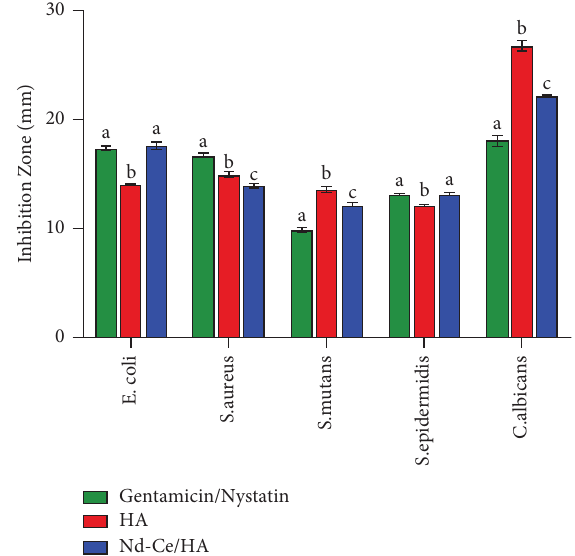
Figure 6: Bar graph exhibited antibacterial and fungicide activity of HA and Nd-Ce/HA (diferent letters ( a , b , c ) are signifcant at p < 0 .